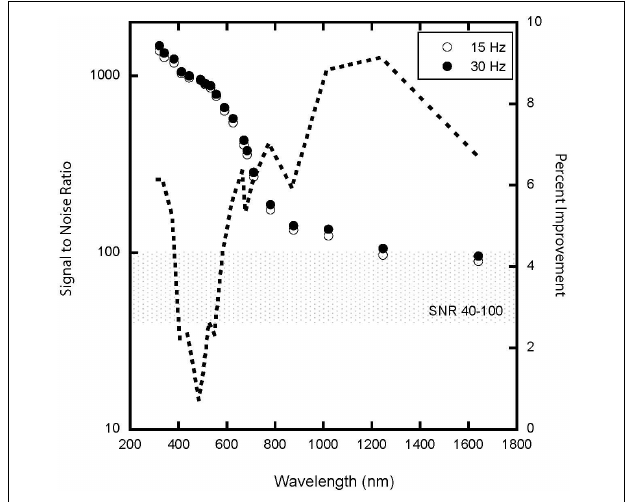
FIGURE 7 | Effective signal-to-noise ratio (SNR) calculated at LSA for C-AERO data over Monterey Bay, CA collected 26 October 2018 (C-HARRIER) with C-AERO at 15 and 30 Hz. The stippled region identifies an optimal SNR of 40–100, while the dashed line provides the percent difference in SNR for 15 versus 30 Hz otherwise processed using the same methods. The percent improvement (as percent increase in SNR when collecting at 15 versus 30 Hz) is shown as the dashed